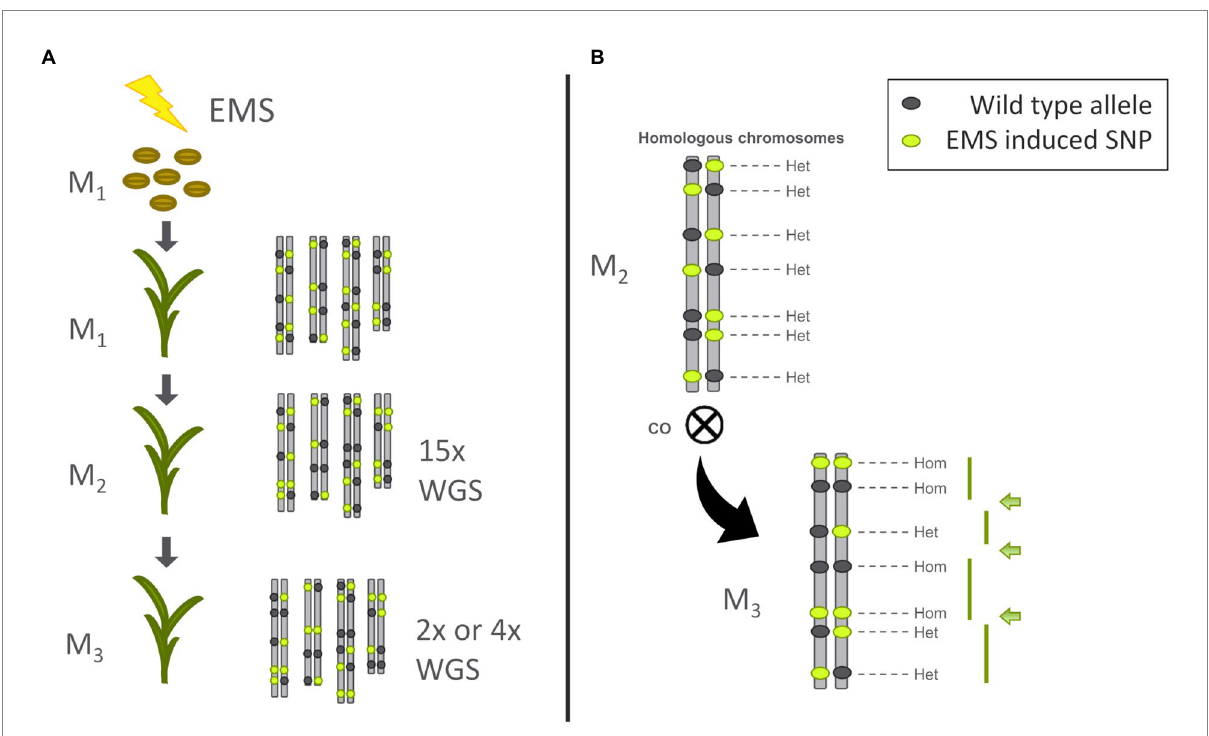
FIGURE 1 Experimental setup. (A) Overview from ethyl methanesulfonate (EMS) treatement to whole genome shotgun sequencing (WGS) (B) Counting of cross overs (CO) in the M3